Question: Describe this figure in one sentence.
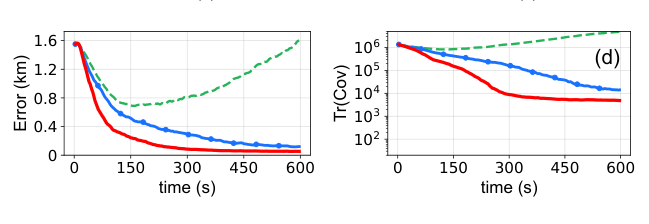
Answer: Object following results showing estimation error and uncertainty of estimates (position components of the covariance matrix) as Tr(Cov) from 50 unique initial states × 30 MC simulations per method. The median values are plotted at each time step for: (a) Random Walk, (b) Constant Velocity, (c) CV-IFT, and (d) CV-IFT with mismatched filter (the hard estimation problem setting). More effective planning decisions with our MEXGEN method yield improved tracking accuracy and lower uncertainty over time.